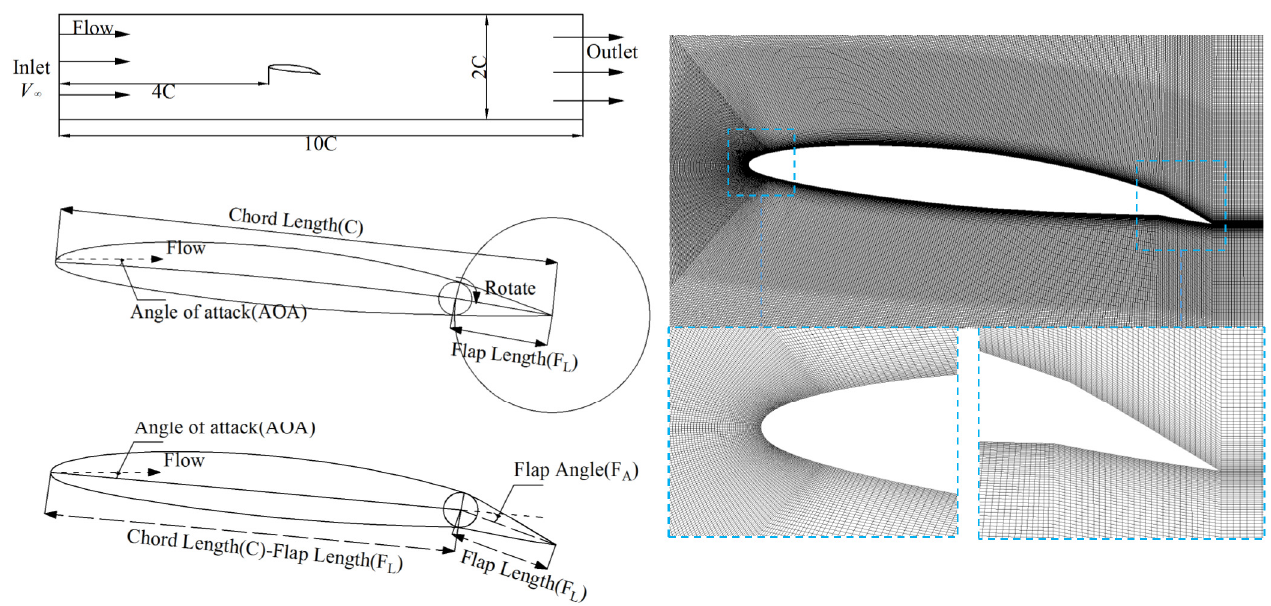
Figure 2. Fluid domain and fluid mesh.